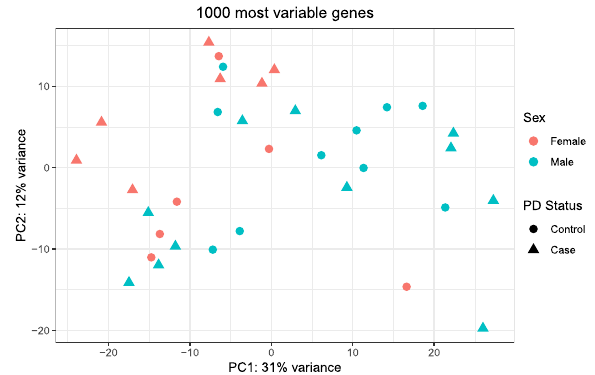
Fig. 2 Principal component analysis reveals primary effect of sex on gene expression. Principal Component Analysis (PCA) of the 1000 most variably expressed genes in monocytes from our RNA- seq dataset was conducted and the fi rst two principal components were plotted. A primary effect of sex on gene expression was observed. Circles represent healthy control subjects ( n = 16) and triangles represent PD subjects ( n = 18); females ( n = 13) are fi lled orange and males ( n = 21) are fi lled light blue.